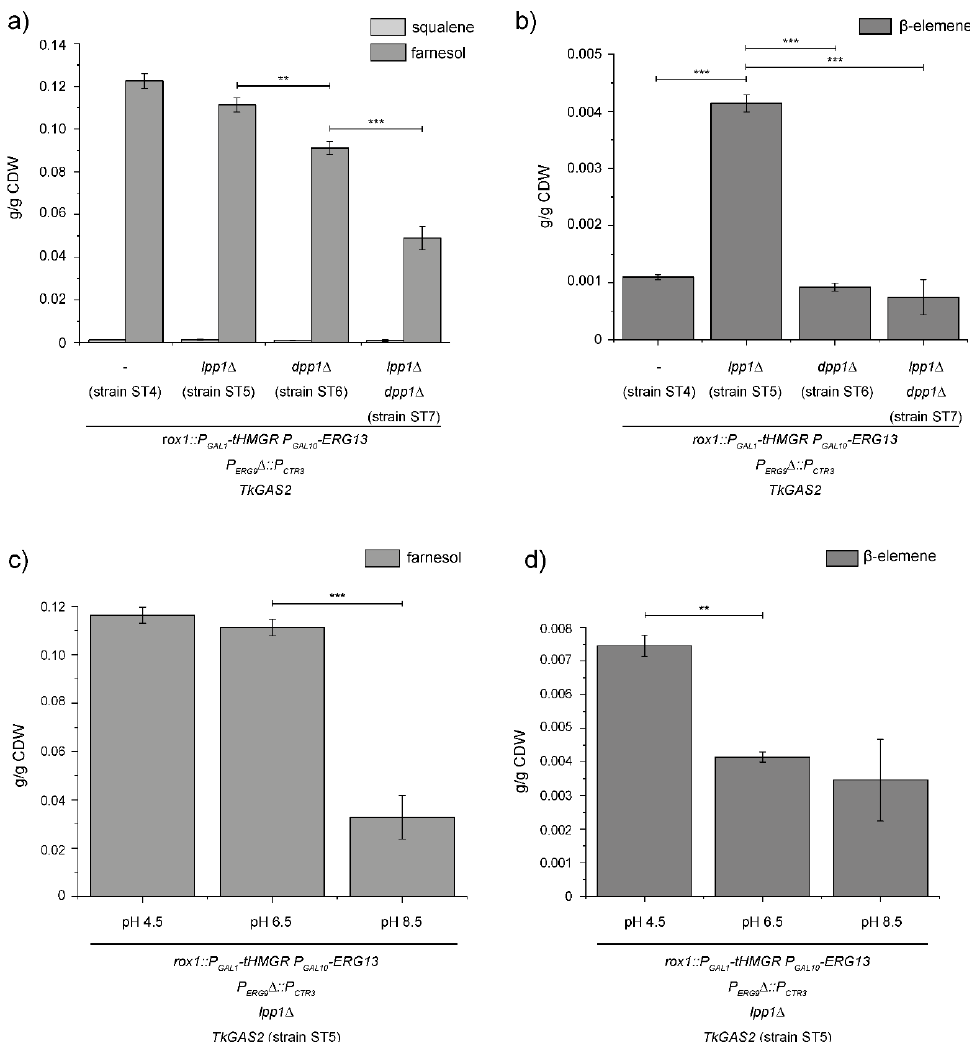
Figure 3. Enhanced germacrene-A synthesis by inhibition of FPP degradation. ( a ) Squalene and trans-trans- farnesol levels in yeast strains harbouring the phosphatase knockouts. Yeast strains carrying the premature stop codon in the LPP1 ( lpp1 ∆ , strain ST5) and / or DPP1 ( dpp1 ∆ , strain ST6; lpp1 ∆ dpp1 ∆ , strain ST7) coding sequence showed comparable squalene levels as the control strain ST4, confirming the repression of sterol biosynthesis pathway upon addition of 150 µ M CuSO 4 . The yeast strain carrying the single LPP1 knockout showed a slightly reduced synthesis of trans-trans- farnesol (strain ST5). A more significant decrease was detected for the strain carrying the DPP1 knockout (strain ST6). ( b ) Germacrene-A synthesis of yeast strains harbouring the phosphatase knockouts. In contrast